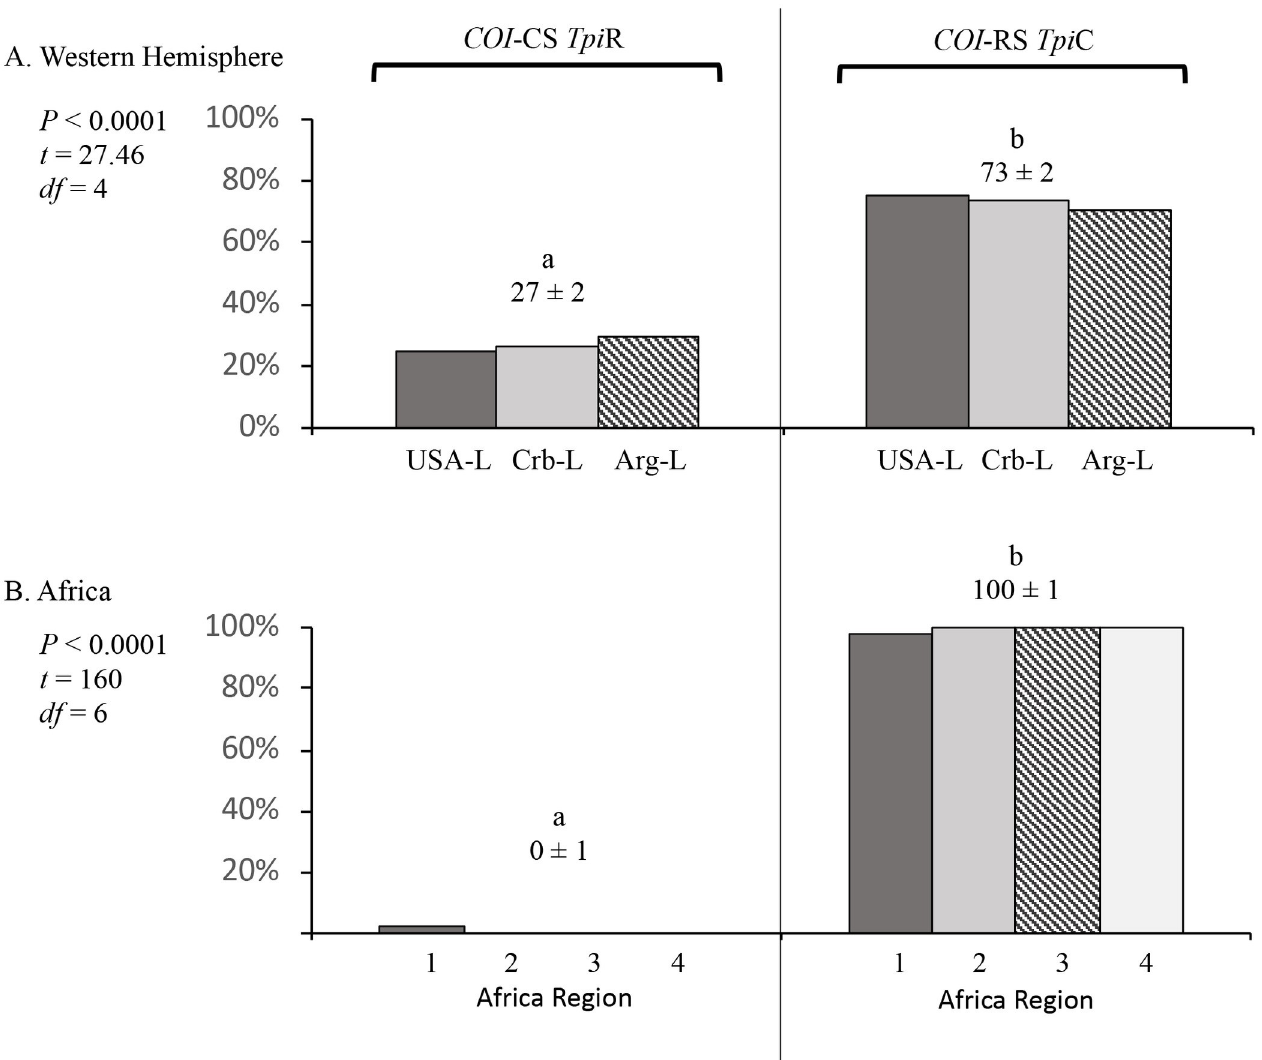
Fig 4. Comparison of the COI -CS Tpi R and COI -RS Tpi C configuration frequencies that make up the discordant category described in Fig 3. The mean frequency ± SD is listed for each category. Pair-wise comparisons between the means were calculated using single-tailed t -test with significant differences indicated by different lower-case letters. (A) Western Hemisphere collections. (B) Africa collections. The same collections were used as in Fig 3. All collections were from corn-strain preferred host plants.